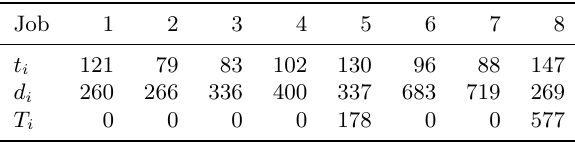
Table 2: Revised schedule following a